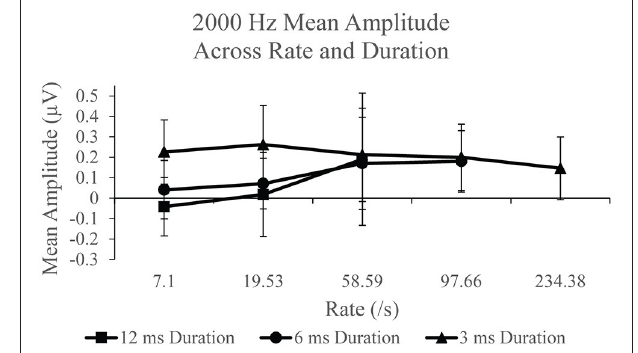
FIGURE 6 | Mean SP amplitude values for the 12 ms duration, 6 ms duration, and 3 ms duration as a function of repetition rate for the 2,000 Hz